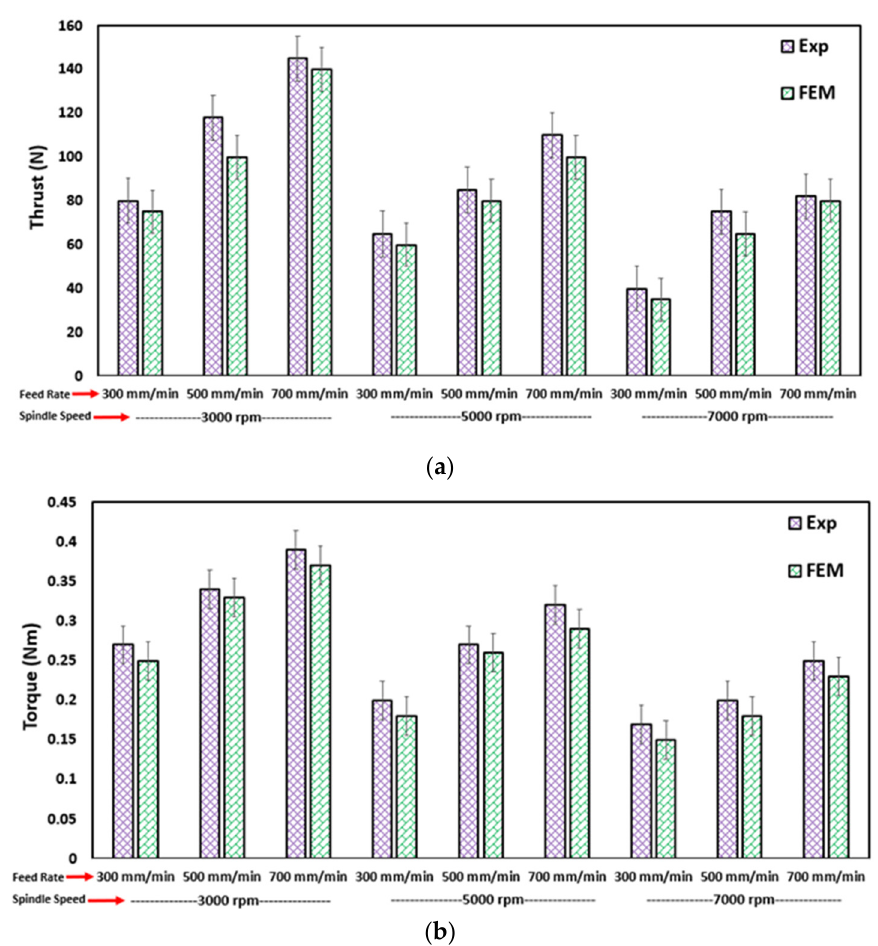
Figure 5. Comparison of the model prediction and experimental results at various feed rates and spindle speeds: ( a ) thrust force and ( b ) torque.